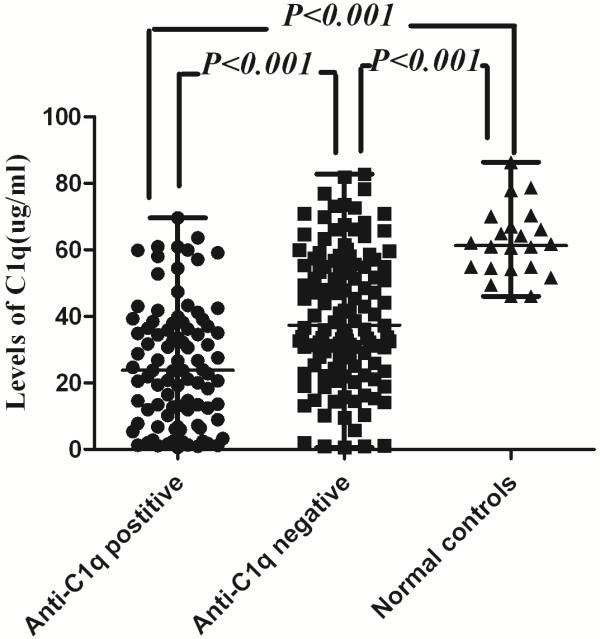
Comparison of serum C1q levels in patients with lupus nephritis with positive or negative anti-C1q antibodies and normal controls. The horizontal lines indicated the median value and range.